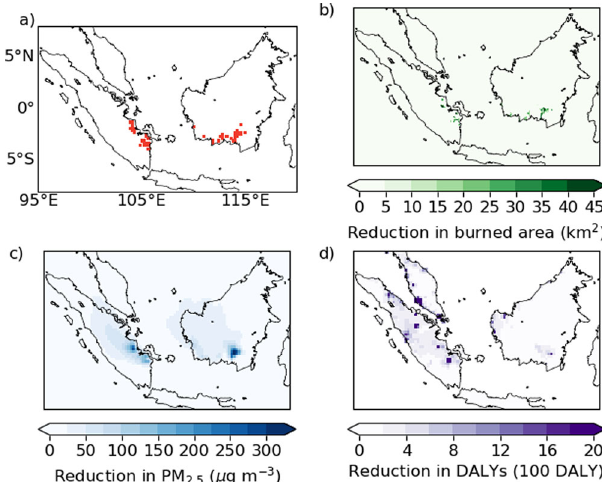
Fig. 3 The potential impacts of peatland restoration on August – October 2015 fi res. Locations of peatland restored in this study are shown in red ( a ). Reductions in burned area ( b ), average PM 2.5 concentrations ( c ), and Disability Affected Life Years (DALYs) from PM 2.5 exposure ( d ) due to peatland restoration are shown by the green, blue, and purple colour scales,